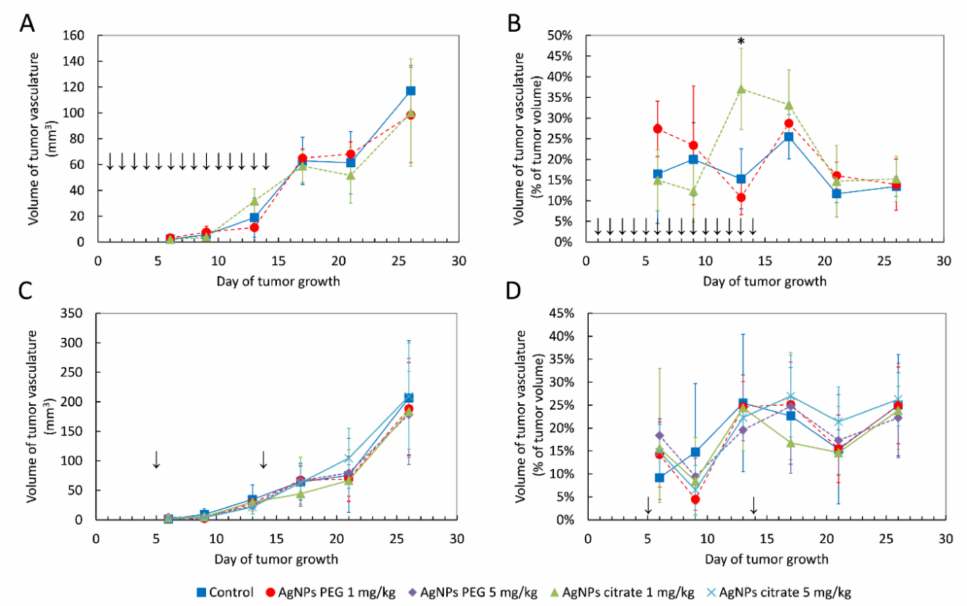
Figure 3. The volume of blood vessels in tumor tissue shown as an absolute value or as a percent of tumor volume in mice treated intragastrically ( A , B ) or intravenously ( C , D ) with citrate- and PEG- coated AgNPs. Arrows indicate AgNPs administration. Data are presented as the mean ± standard deviation, n = 6. * p <